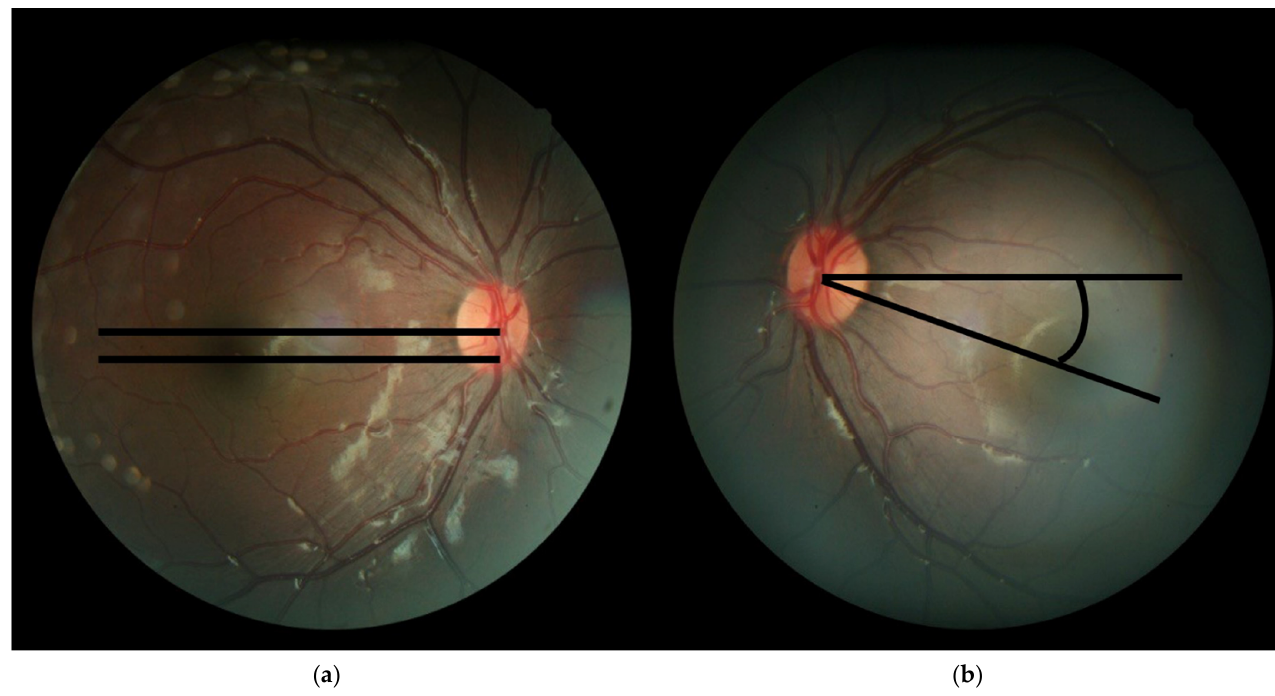
Figure 1. Assessment of objective ocular torsion on fundus photography. ( a ) D The cyclotorsion angle was measured from two straight lines: the first line passing through the of the geometric center of optic disc and the second line joining the center of the optic disc to the fovea; ( b ) Eye fundus with excyclotorsion: Extorsion was defined by the fovea located below the lower edge of the optic disc. Angle is the degree between the straight line passing through the optic disc connecting the macula and the reference line.